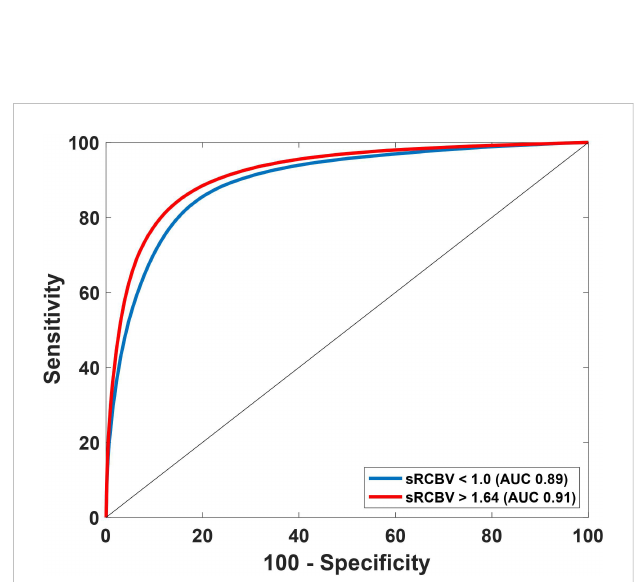
FIGURE 2 Receiver Operating Characteristics (ROC) curve using sRCBV values to identify the dual-echo thresholds. The AUROC for thresholds 1.0 and 1.64 are 0.89 and 0.91 respectively.